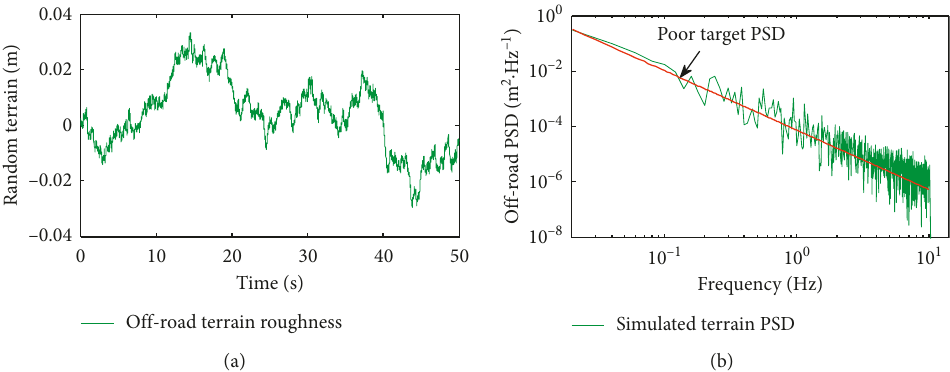
Figure 3: Generation of the off-road terrain roughness according to unpaved off-road classification. (a) Off-road terrain profile. (b) Spectral densities.